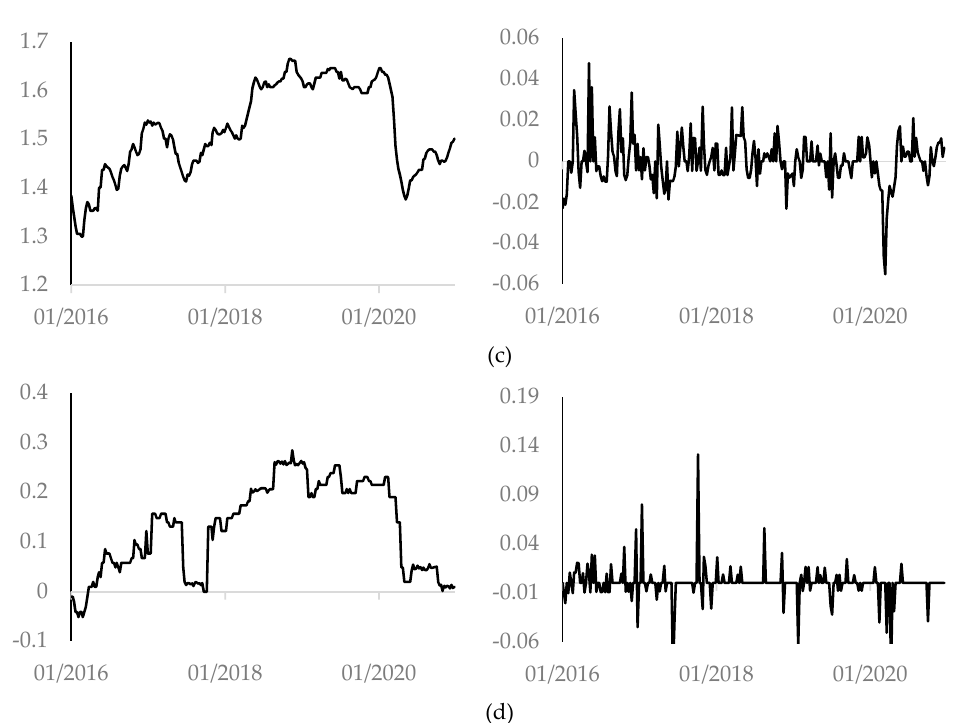
Figure 2. Diesel logarithmic weekly prices (left panel) and returns (right panel) in the Czech Republic ( a ), Hungary ( b ), Poland ( c ) and Slovakia ( d ) from January 2016 through December 2020. Source: own elaboration.